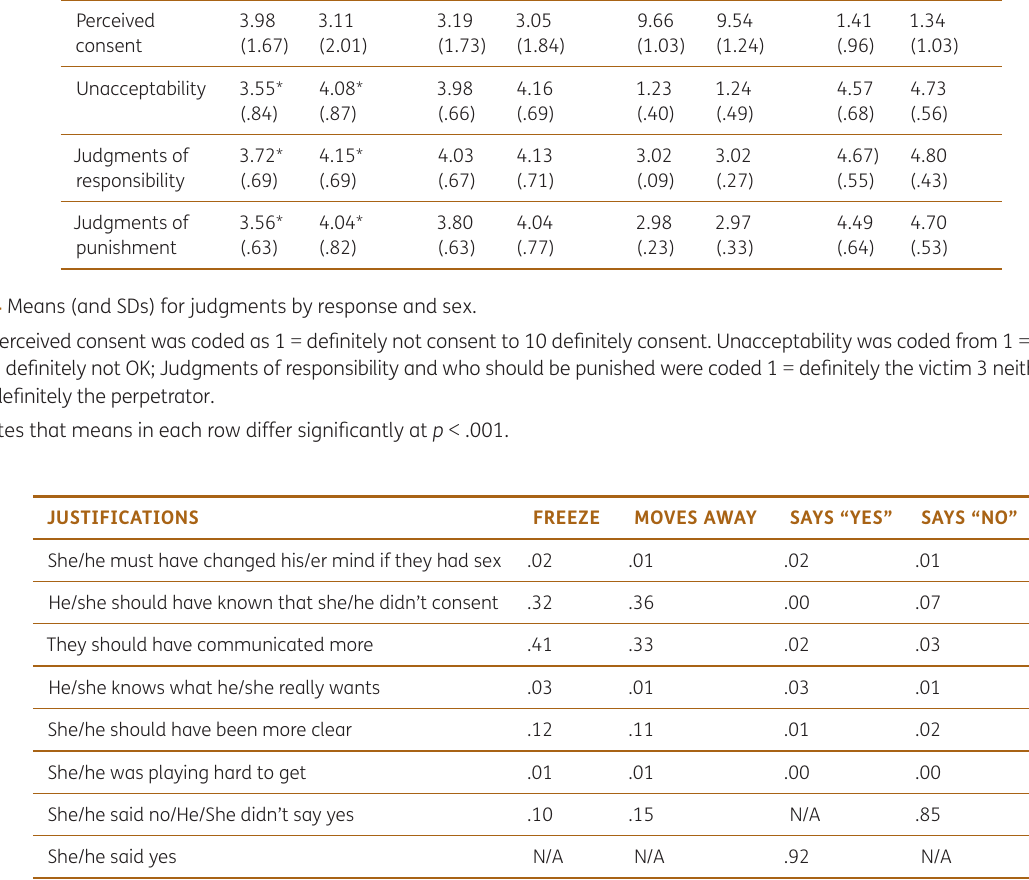
Table 5 Justification for Evaluations of the Interaction. Note : Participants selected one of these justification choices after evaluating the